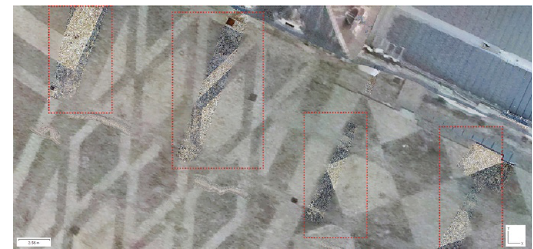
Figure 13. Details of the radiometric and resolution discontinuity in orthophoto generated using images from both sensors.